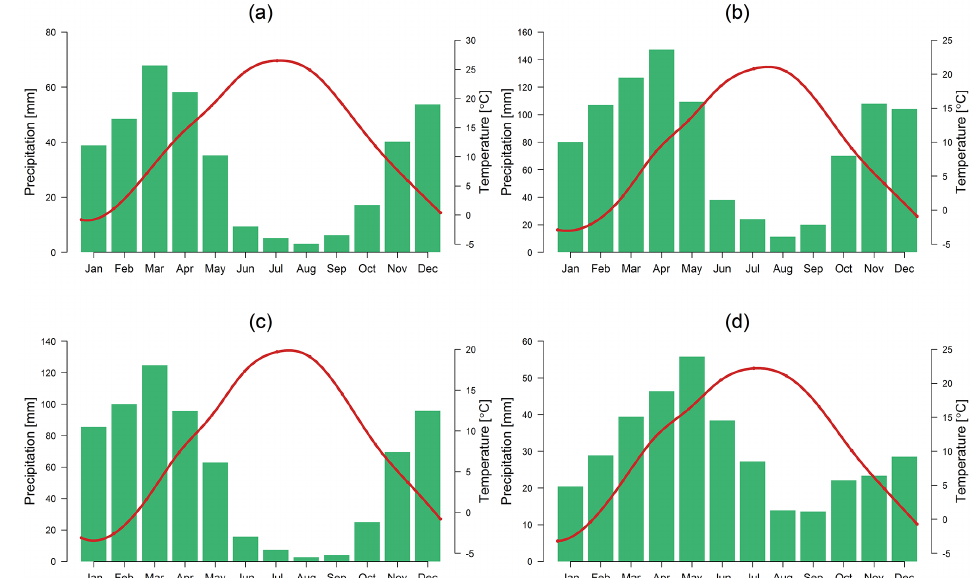
Figure 5. The 30-year means (1984–2013) of monthly temperature ( ◦ C, red line) and precipitation (mm, green bars) at four selected stations, namely Gallyaaral in the Zerafshan basin (a) , Chimgan in the Chirchik–Akhangaran basin (b) , Mingchukur representing the Kashkadar’ya and Surkhandar’ya basins (c) , and So’x in Fergana Valley (d) , with high occurrences of mudflow in Uzbekistan. The graphs have different